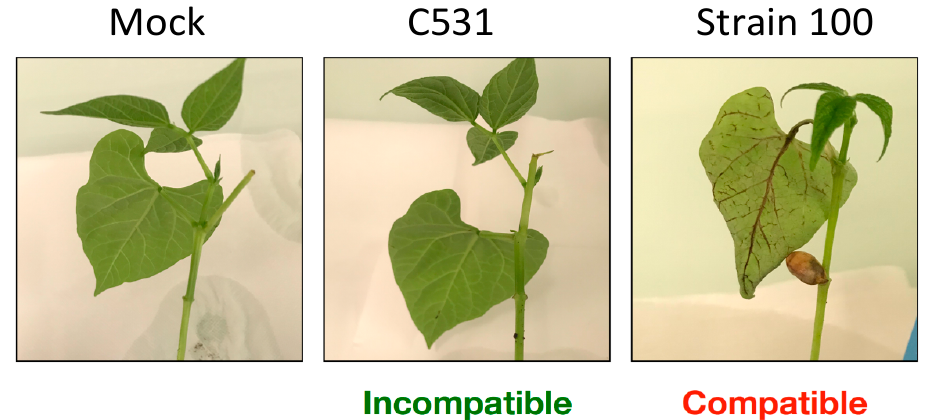
Figure 1. Infection characteristics of C. lindemuthianum on common bean plants. Typical symptoms on cotyledonary leaves at 6 days post-infection on representative BAT93 plants.